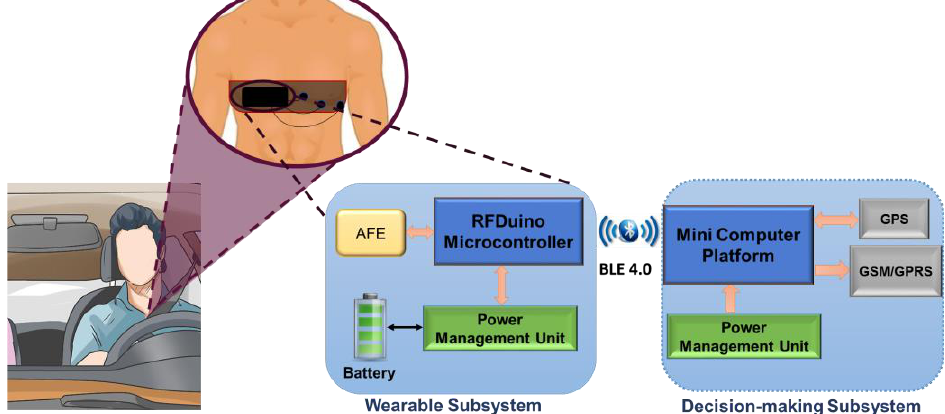
Figure 2: Block diagram of the prototype system Figure 2. Overall system block diagram. Figure 2. Overall system block